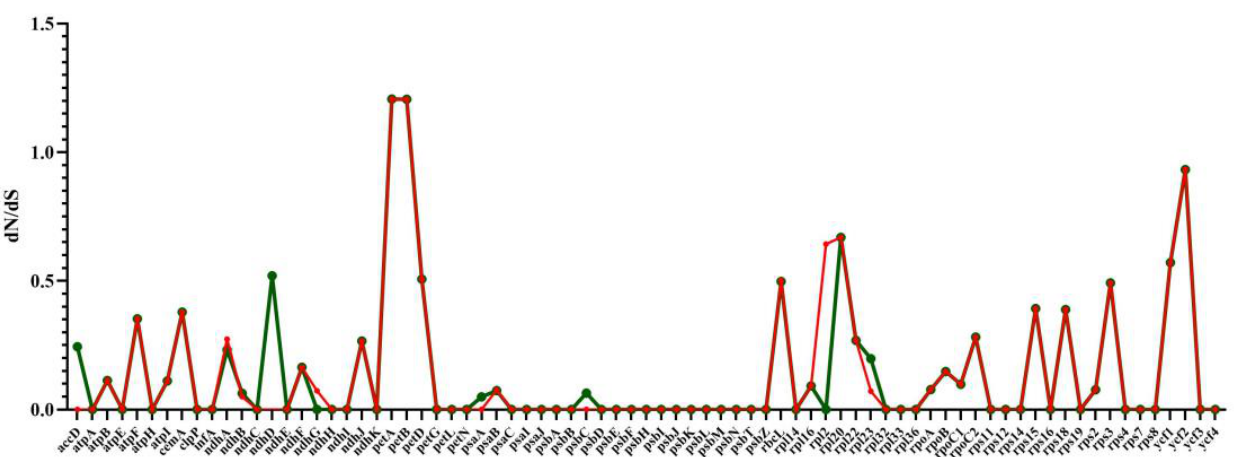
Figure 11. The dN/dS ratio values of common protein-coding genes in U. macrophylla , U. hirsuta, and U. rhynchophylla .